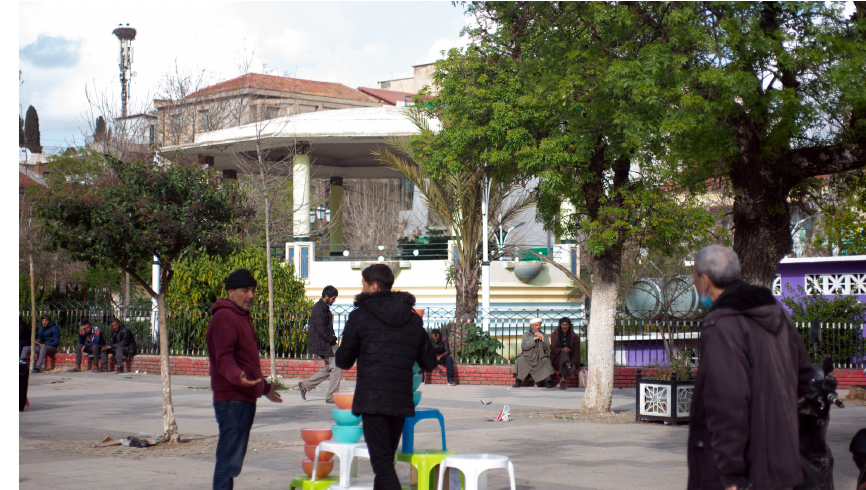
Fig. 5. November 1st 1954 Square of Medea. Support for various illicit commercial activities and improvised parking in the centre of this public place.